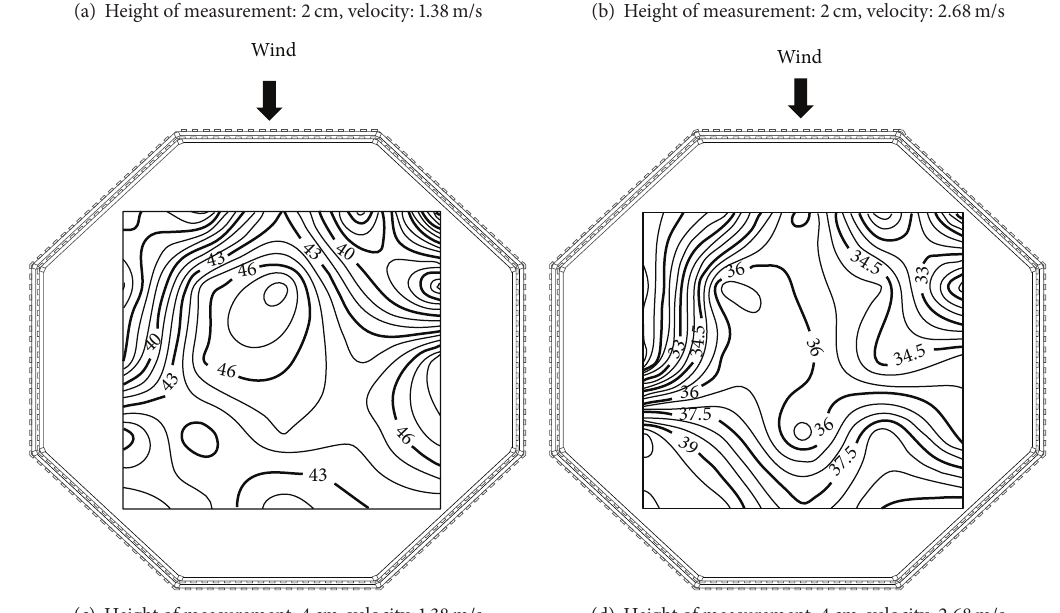
(b) Height of measurement: 2cm, velocity: 2.68m/s